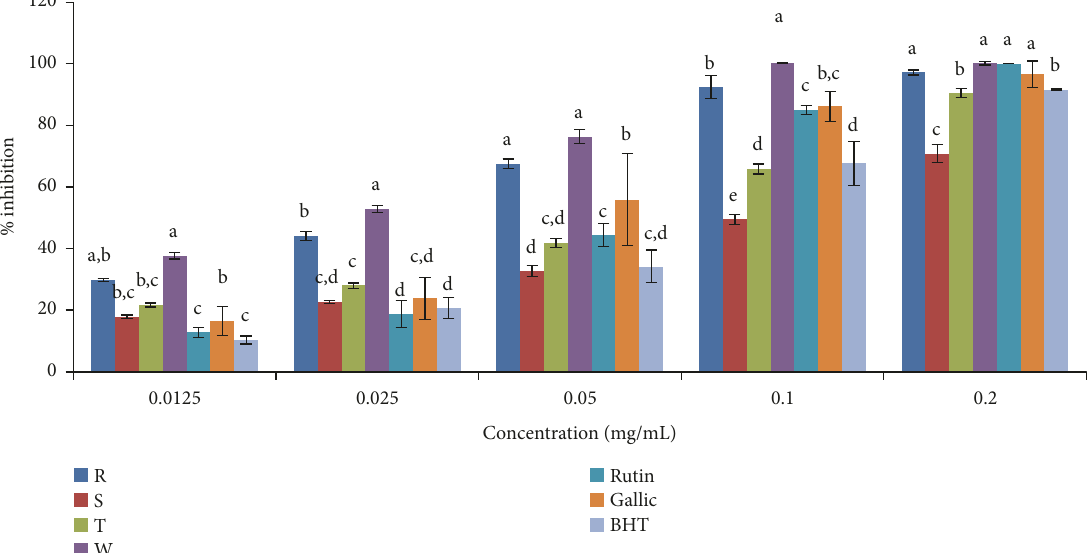
Figure 4: ABTS + radical scavenging activity of ethanolic extract of the four varieties of Capsicum species. Values are mean ± SD of three replications. Set of bars having different letters are significantly different at (p < 0.05). R= C. annuum var. abbreviatum , S= C. annuum var. acuminatum , T= C. annuum var. grossum , and W= C. frutescens var . baccatum .